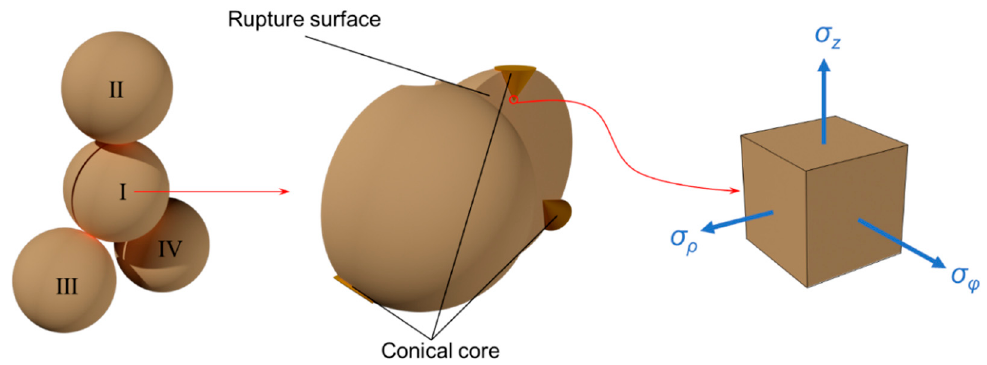
Figure 8. A sketch of the breakage form for Particle I and the stress state of the conical core vertex at the contact point between Particles I and II.